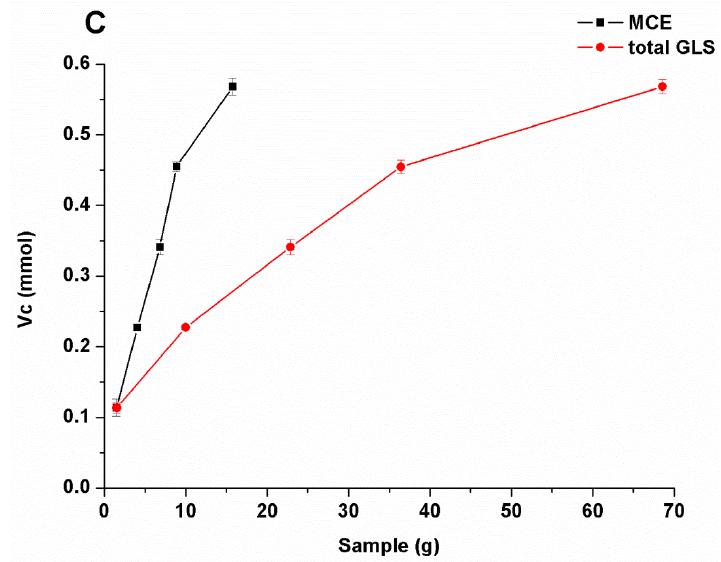
Figure 3. Antioxidation activities of GLS and their enzymolysis product. ( A ) 1,1-diphenyl-2-picrylhydrazyl (DPPH) radical scavenging activity of Maca crude extract and total GLS at 0.5–10 mg/mL, ( B ) 2,2 ′ -azino-bis-(3-ethylbenzothiazolin-6-sulfonic acid) (ABTS) radical scavenging ability of total GLS and Maca crude extract solutions at 0.5–10 mg/mL, and ( C ) the re- ducing power of Maca crude extract and total glucosinolates.